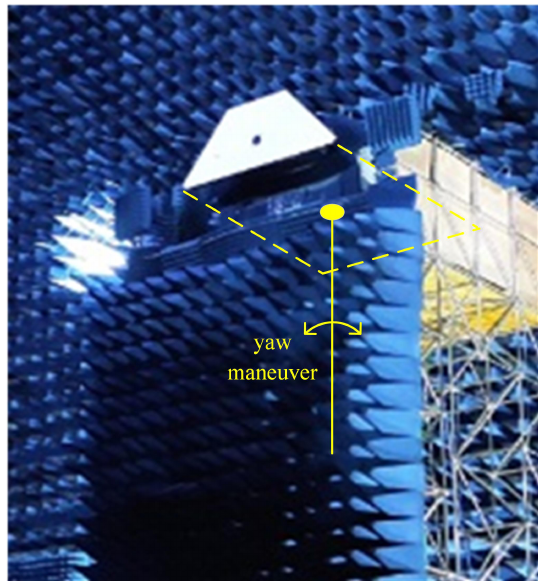
Figure 13. RL-based APC calibration in laboratory HIL environment. Prior parameters of NN from a previous RL training process are used for the HIL APC calibration system, including weight and bias data sets. The trained NN program is compiled and uploaded to the HIL control system, and Figure 14 provided the results of reward values during HIL APC simulation. Obviously, we get the sharp vibrated data this time, compared with ACS simulation. The reason for this phenomenon is mainly due to the platform rotation control system, which is not smooth enough in angular rate control. However, the final trained APC calibration error can still be achieved to less than 2 mrad, as in zoomed in subfigure of Figure 14.